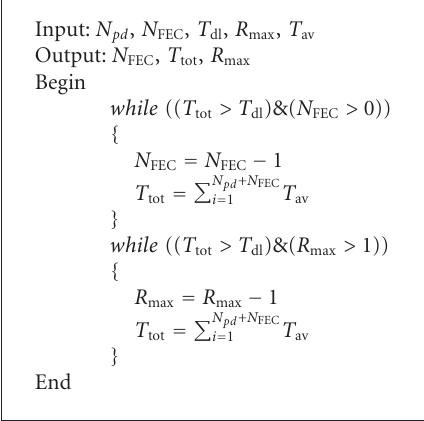
Algorithm 3: Enforcing the time constraint at the data-link layer (Algorithm 2